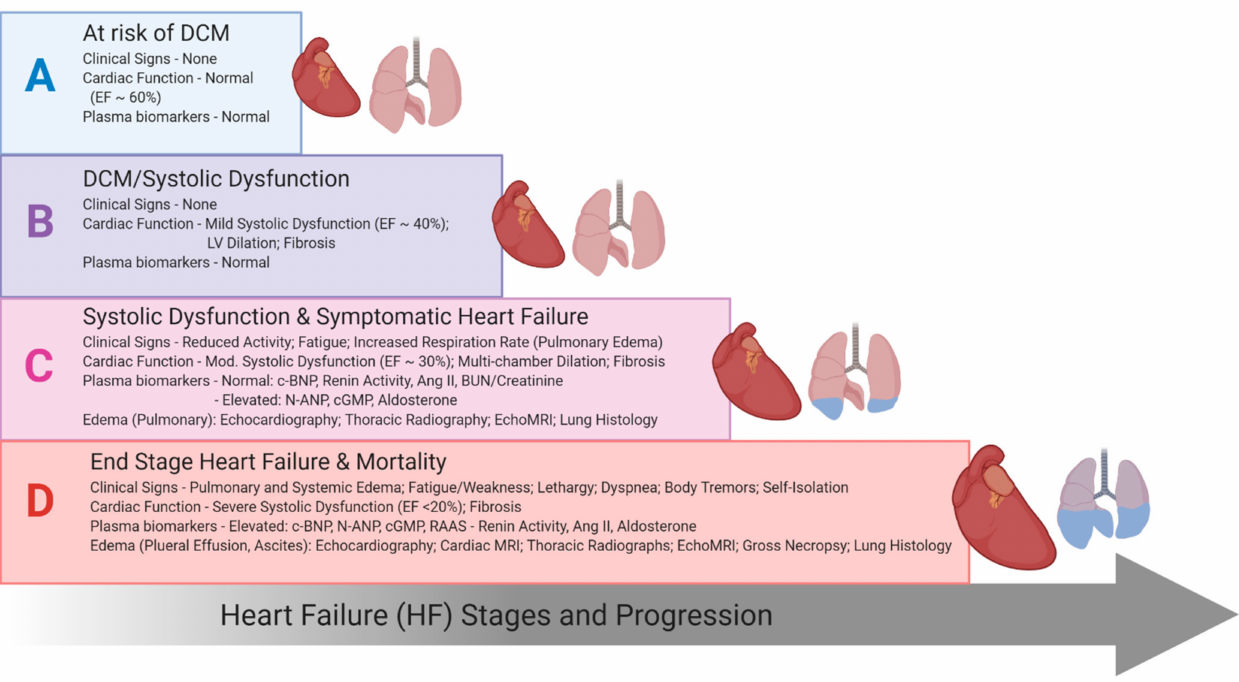
Figure 1. Schematic diagram of progressive heart failure stages in a normotensive dilated cardiomyopathy-heart failure with reduced ejection fraction (DCM-HFrEF) mouse model with preserved renal function based on experimental data on clinical signs, systolic function, diagnostics and blood biomarkers